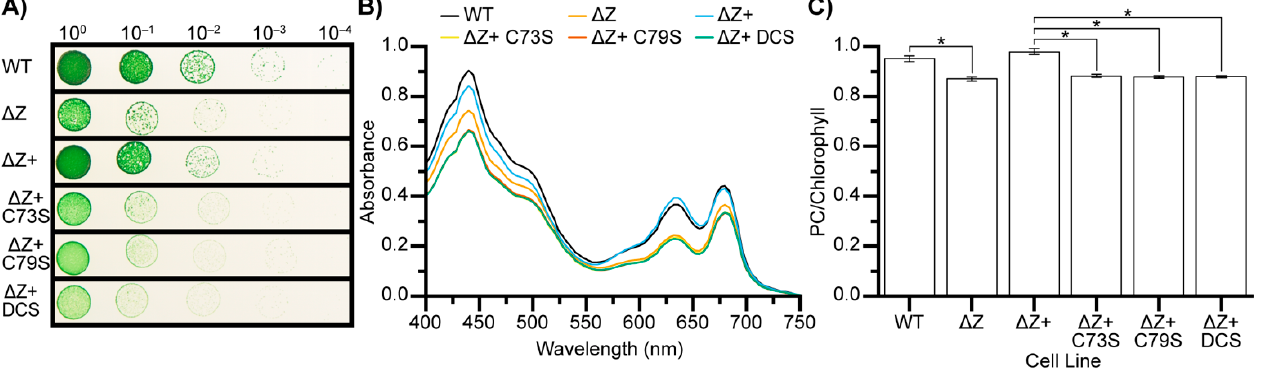
Figure 4. C73 and C79 are required for Zam function in vivo. ( A ) Spot plate showing relative growth of cell lines used in this study. As previously reported Δ Z exhibits a mild growth defect. The mutant complemented lines show the same defect. ( B ) Representative absorption spectrums of cell lines used in this study. Δ Z cells and the mutant complement lines show decreased phycocyanin relative to chlorophyll. ( C ) Average ratio of phycocyanin absorption to chlorophyll absorption for each cell line ( n = 3). Statistical difference determined by Student’s t-test at p = 0.001 indicated by *.